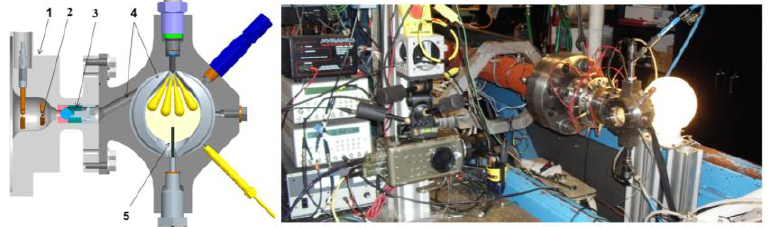
Figure 11. Preheating chamber and OPOC optical combustion chamber assembly: 1—Preheating chamber case; 2—Glow plug; 3—One-way valve; 4—Tangential channel for the swirl generation; 5—Temperature sensor.